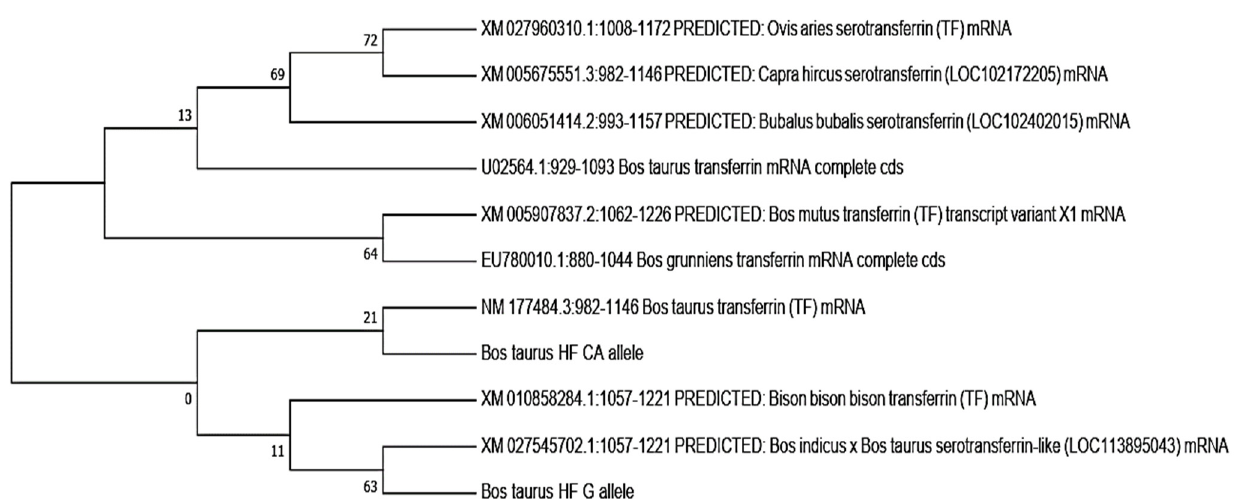
Figure 4. Evolutionary relationships of transferrin genes by using the neighbor-joining